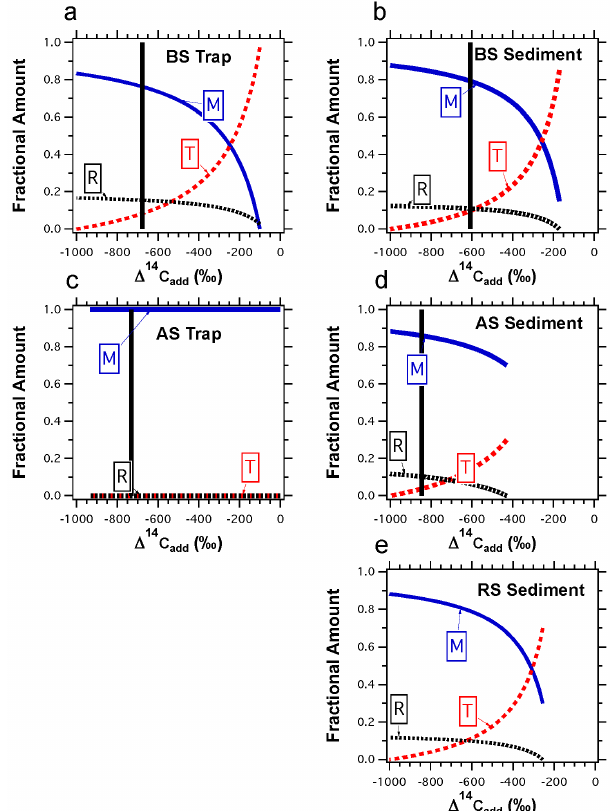
Figure 12. Relative amounts of marine (M, blue solid line), terres- trial (T, red dashed line) and relict (R, black dashed line) carbon as a function of (cid:49) 14 C added in Black Sea and Arabian Sea trap ma- terial ( a and c , respectively) and in Black Sea, Arabian Sea and Ross Sea sediments ( b , d , and e , respectively). Only real solu- tions are depicted. The solid black line indicates the solution when (cid:49) 14 C added is equal to the value measured on compounds defined as relict. There are not enough data to construct a graph for the Ross Sea sediment